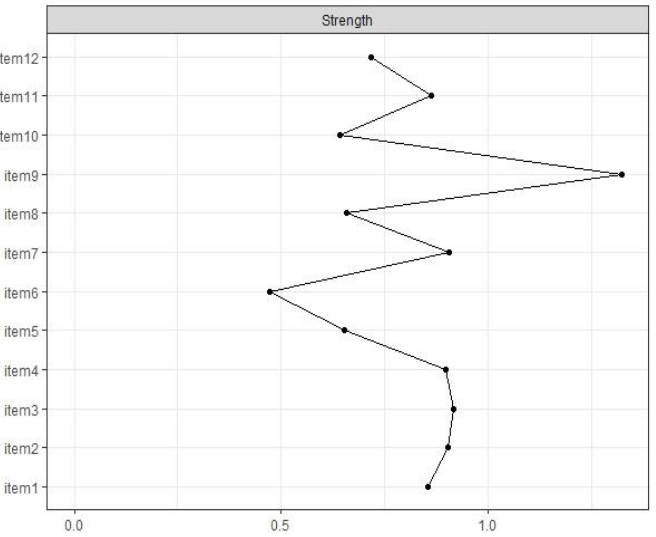
Figure 2. Standardized centrality measure for strength of all items of the FoP-SF.